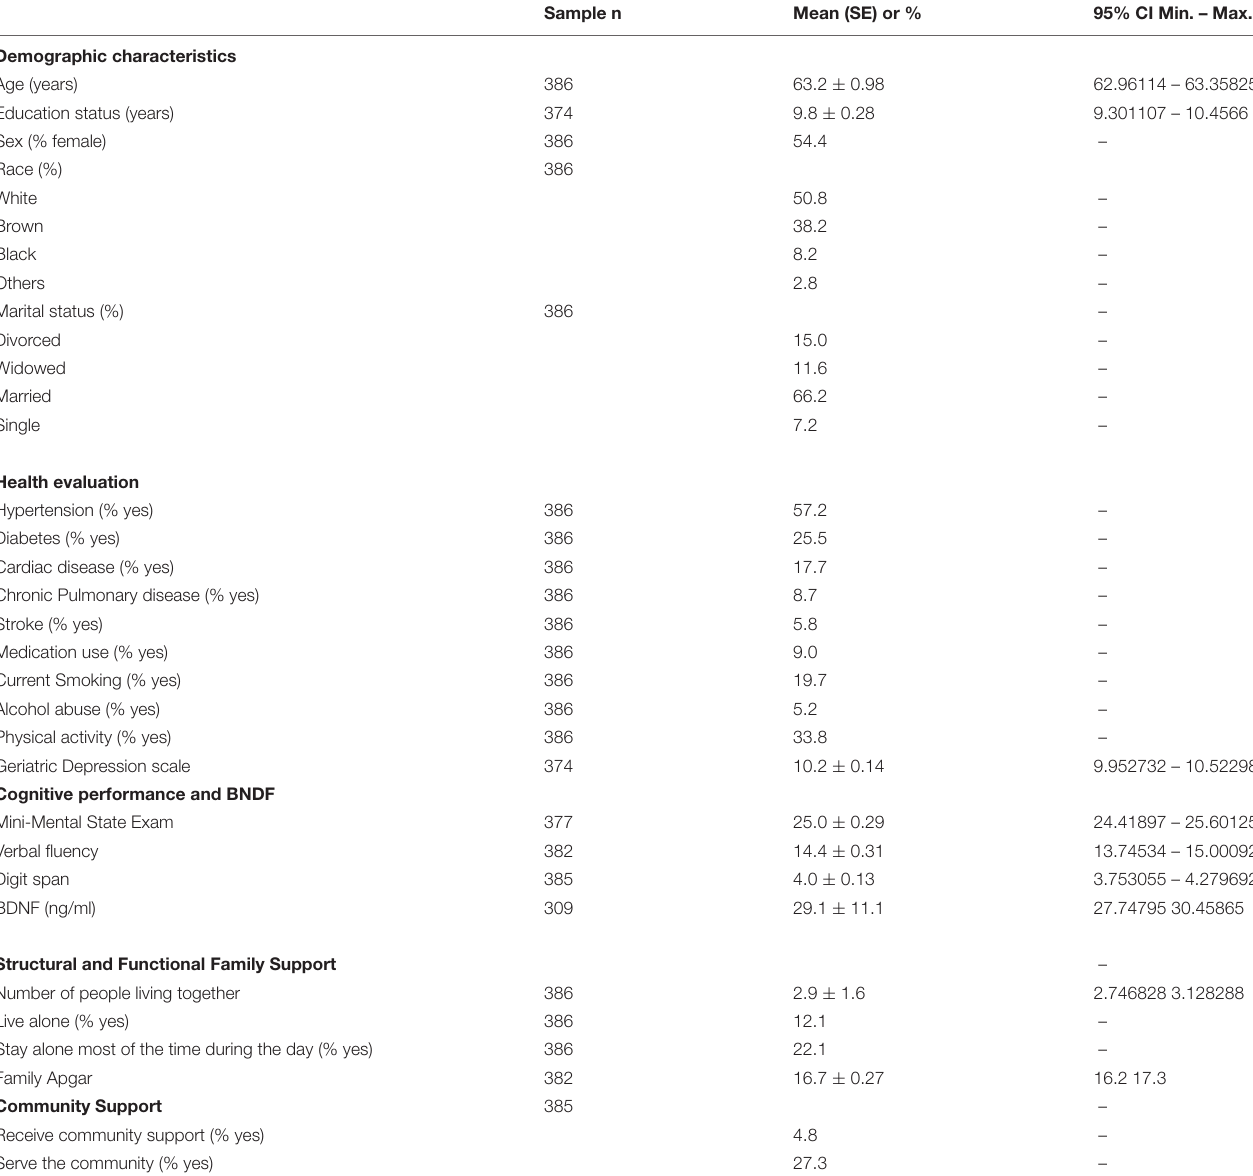
TABLE 1 | Demographic characteristics, health evaluation and cognitive performance of the participants. Sample n Mean (SE) or % 95% CI Min. –